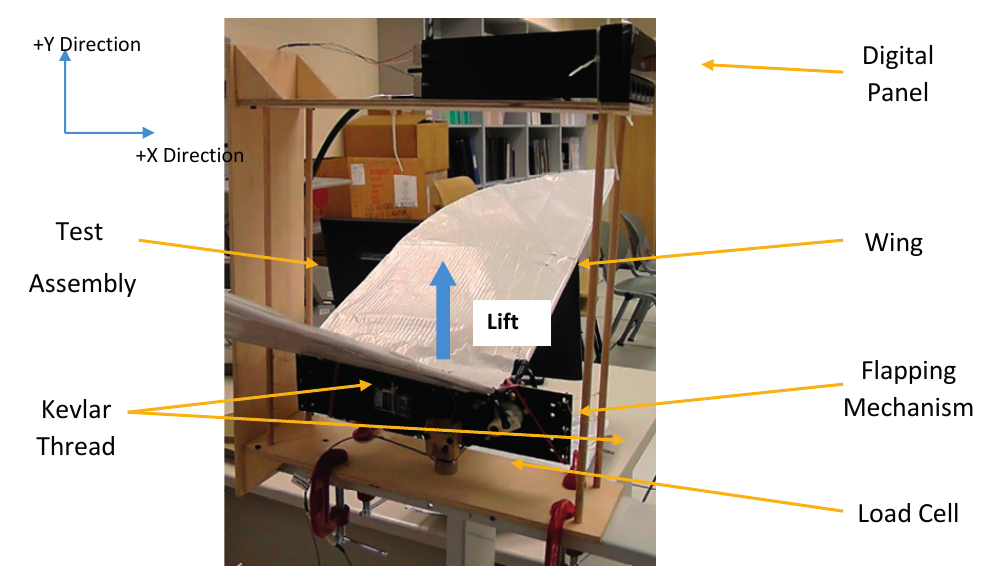
Figure 31. Load cell lift measurement